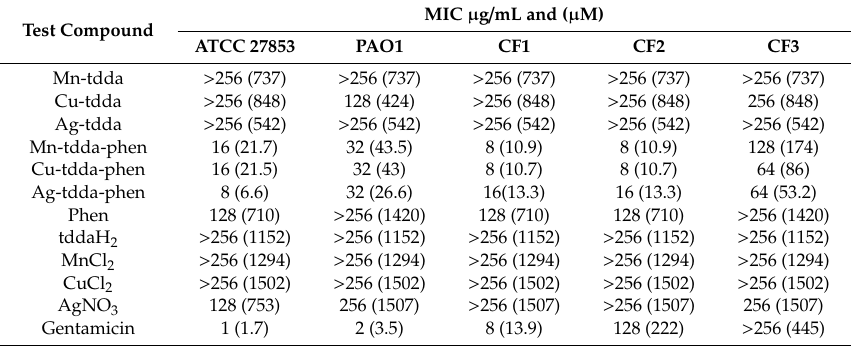
Table 1. E ff ects of test compounds on planktonic growth of P. aeruginosa laboratory strains (ATCC 27853 and PAO1) and clinical isolates